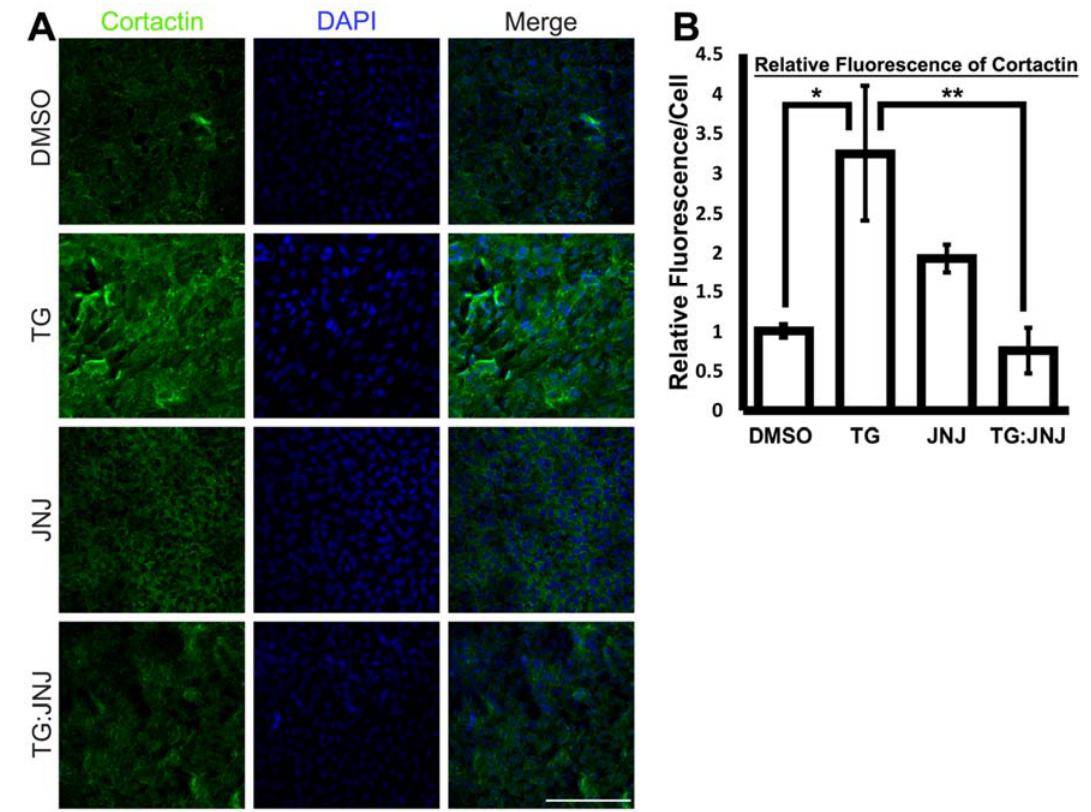
Figure 5. Expression of cortactin upon MMP9 inhibition. Rat LEC explants were treated with DMSO, with 6 ng/mL TGF- β for 48 h (TG), with the MMP9-specific inhibitor, 20 µ M JNJ0966 (JNJ) for 48 h, or pretreated with 20 µ M JNJ0966 for 2 h followed by 6 ng/mL TGF- β for 48 h (TG:JNJ) ( n = 3 independent experiments, where n ≥ 3 LECs per treatment were used for each experiment). ( A ) Paraformaldehyde (PFA) fixed explants were stained for cortactin (green) and mounted with DAPI to visualize the nuclei. Images were acquired using Leica DM6 fluorescence microscope at 40 × . Scale bar, 100 µ m. ( B ) Graph showing mean cortactin fluorescence per cell relative to LECs treated with DMSO. Fluorescence per cell was acquired using Image J ( n ≥ 3 LECs per treatment). Error bars indicate ± SEM of the relative mean fluorescence (One-Way ANOVA shows ** p < 0.01; Tukey’s Test shows * p < 0.05 between DMSO control and TG LECs and ** p < 0.01 between TG and TG:JNJ LECs).